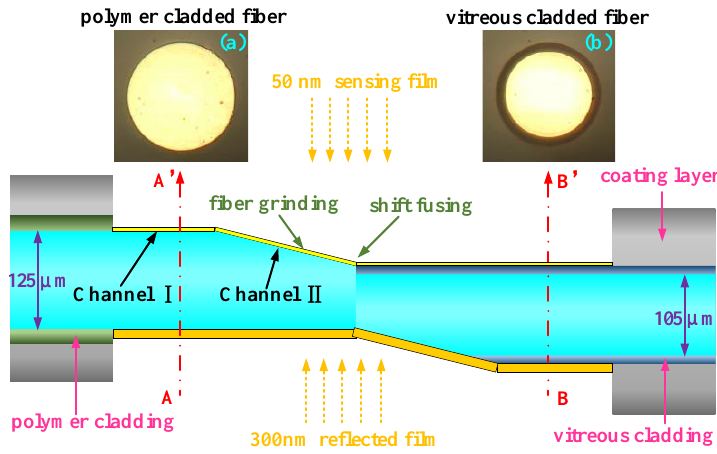
Figure 6. A schematic diagram of the dual-channel SPR sensing probe with the combined applications of the polymer- and vitreous-clad fibers. ( a ) Profile of the polymer-clad fiber; ( b ) profile of the vitreous-clad